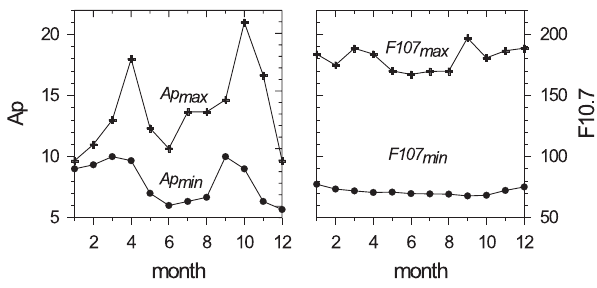
Fig. 11. Seasonal variation of the geomagnetic (left part) and solar activity (right part) for years of low (1996, 2007–2008) and high solar activity (2000–2002).